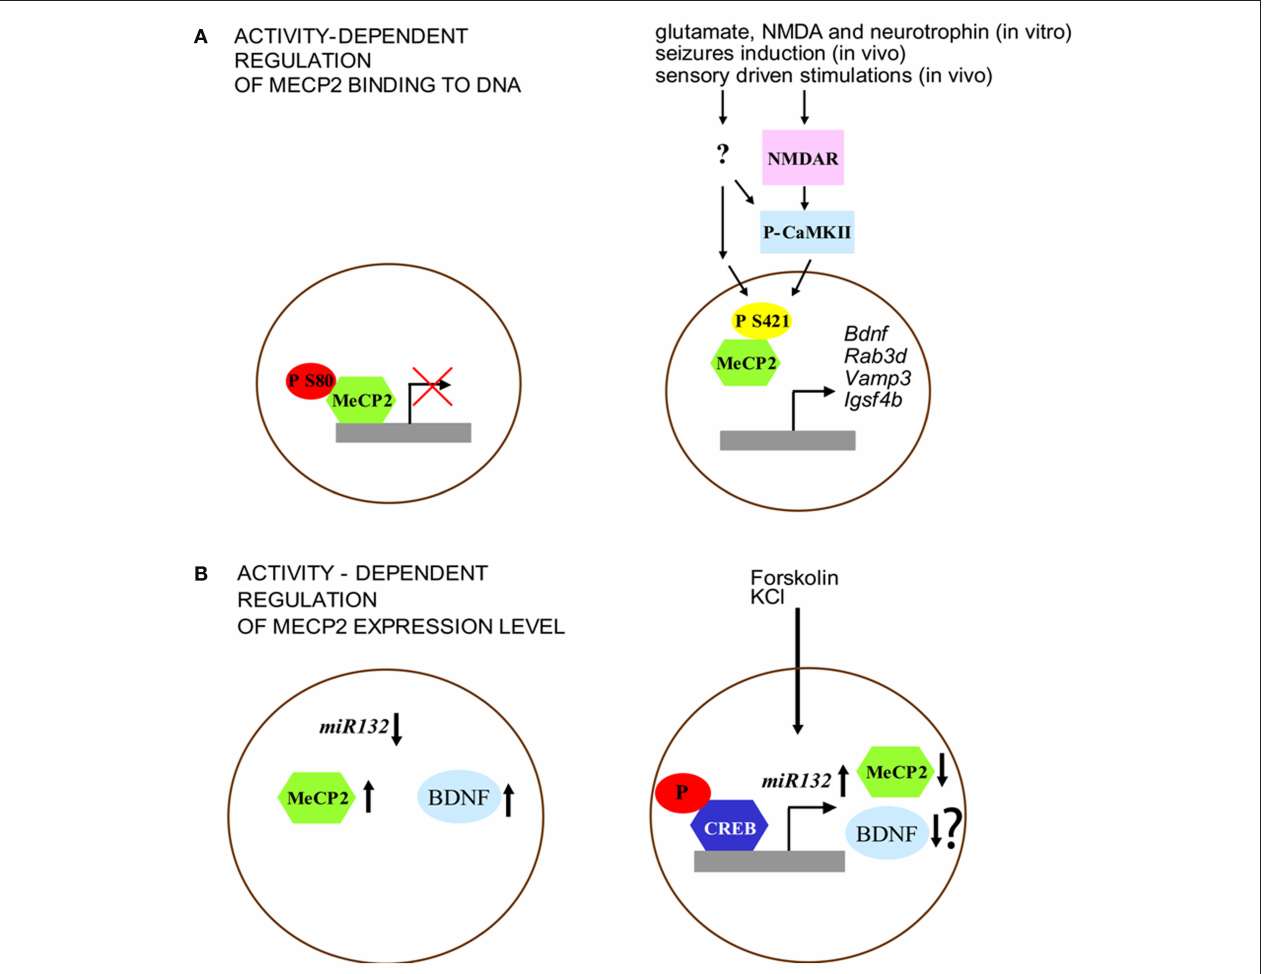
well as blockade of miR132 repression increases BDNF III transcript levels. Right: Forskolin and KCl induce CREB phosphorylation that binds to the miR132 promoter. Increased levels of miR132 reduce MeCP2 expression. Although this model may induce to hypothesize a reduction of BDNF expression, it was not shown by the original paper of Klein et al. (2007) whether the interplay between miR132 and MeCP2, after forskolin and KCl treatment, may affect this neurotrophin